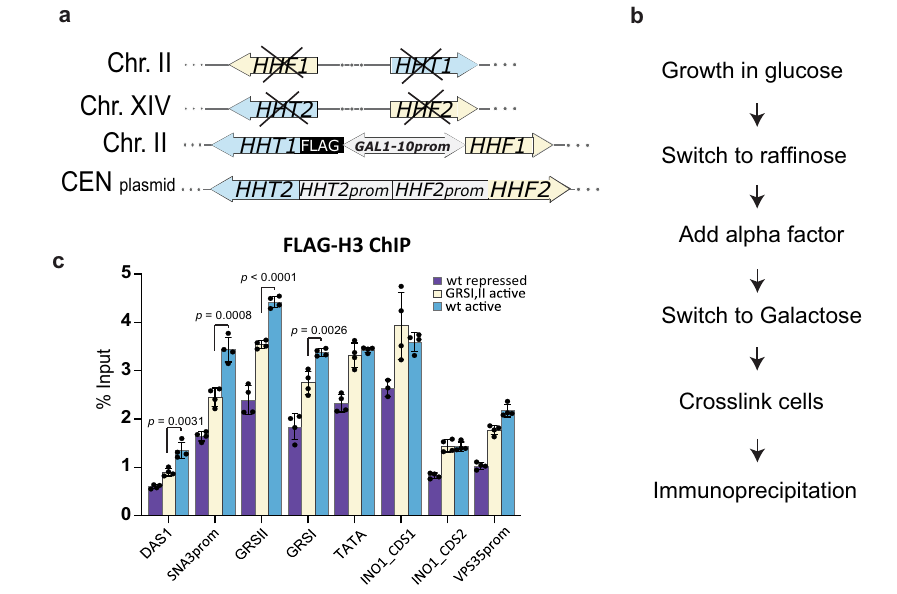
Fig.3|H3exchangeincreaseintheactivated INO1 isaffectedwhenGRSIandII are deleted. a Schematic representation of the strain used to measure the incor- poration of newly synthesized FLAG-H3 into nucleosomes 28 . b Cell sample pre- paration work fl ow before ChIP. For the repressed condition, inositol was added in all the media used. c FLAG-H3 enrichment, as determined by ChIP-qPCR and expressed in percentage of input, in the vicinity of GRS I and GRS II regions within